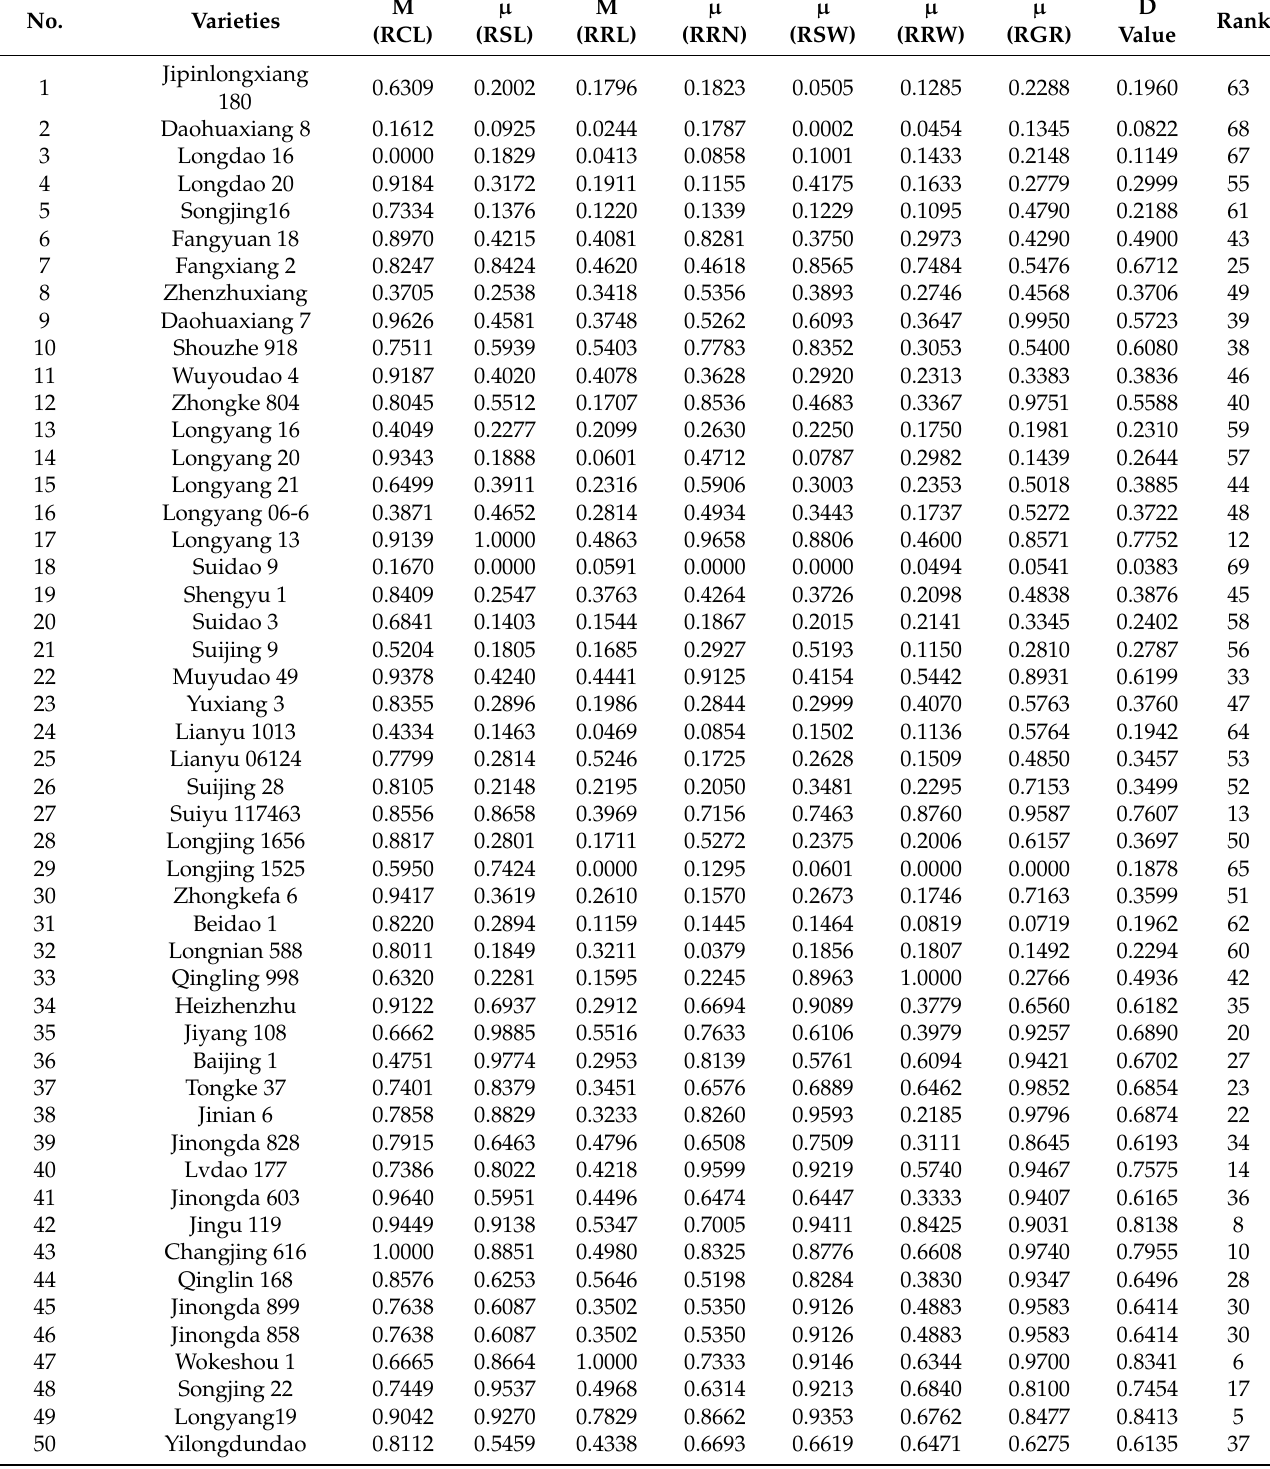
Table 1. Overall evaluation value (D) and ranking of 69 rice varieties in germination trials in